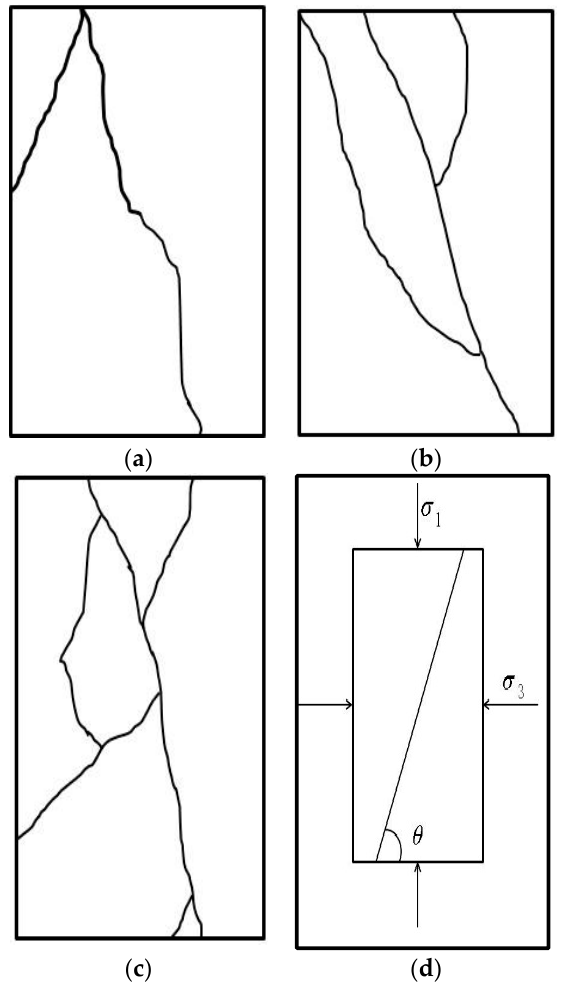
Figure 5. The final crack types and force analysis chart: ( a ) the curve of final crack types under 50 N/s loading rate; ( b ) the curve of final crack types under 100 N/s loading rate; ( c ) the curve of final crack types under 200 N/s and ( d ) the force analysis chart.